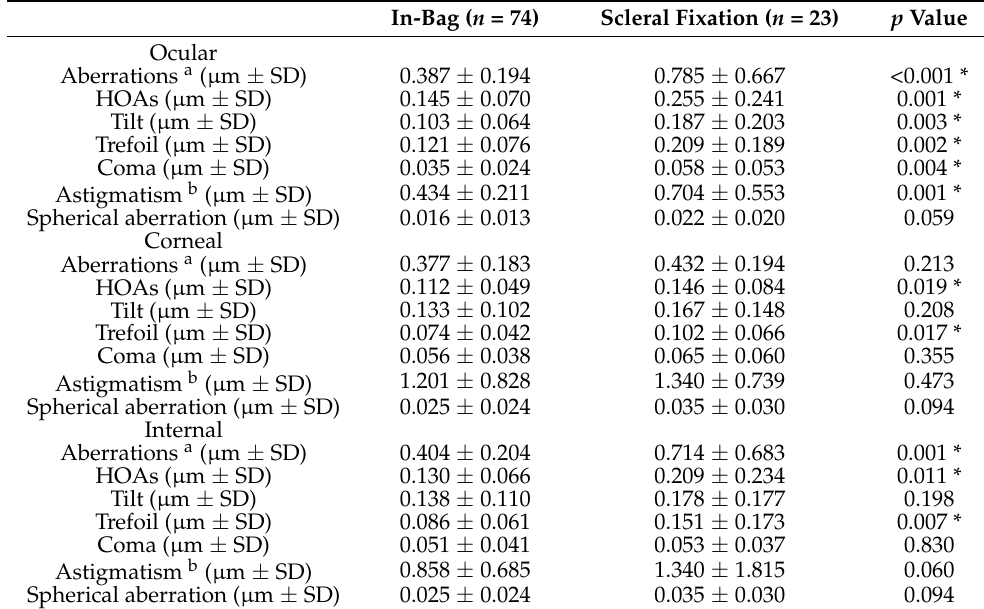
Table 2. Postoperative ocular, corneal, and internal aberrations for 3-mm pupil diameters in eyes following in-bag and scleral-fixated intraocular lens